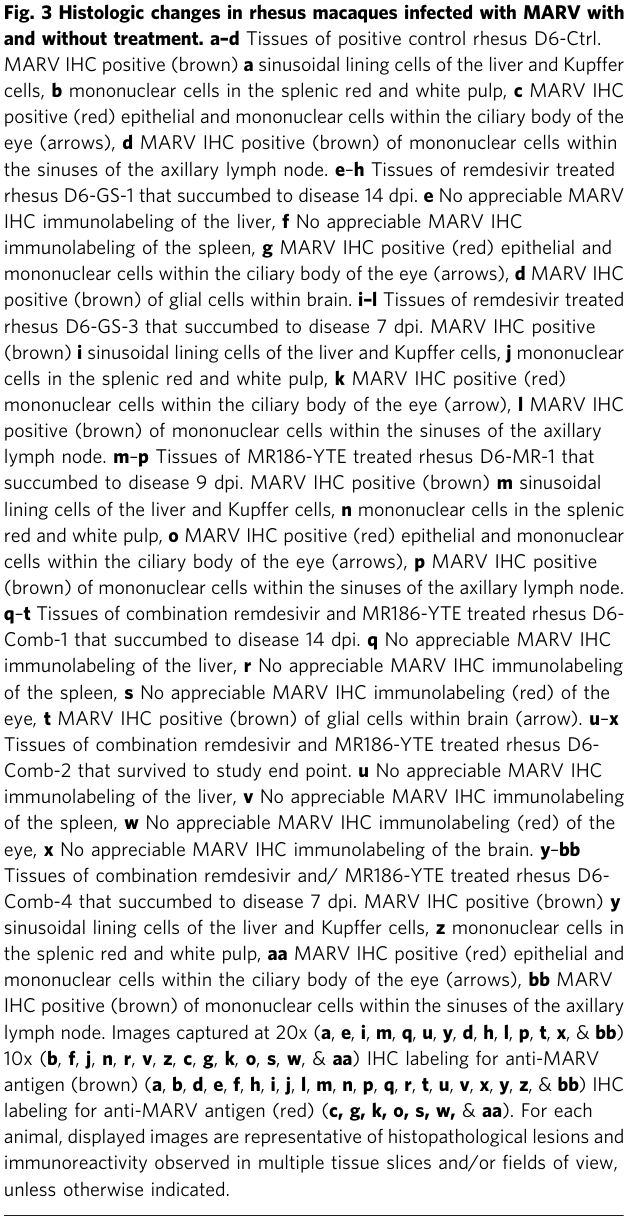
Fig. 3 Histologic changes in rhesus macaques infected with MARV with and without treatment. a – d Tissues of positive control rhesus